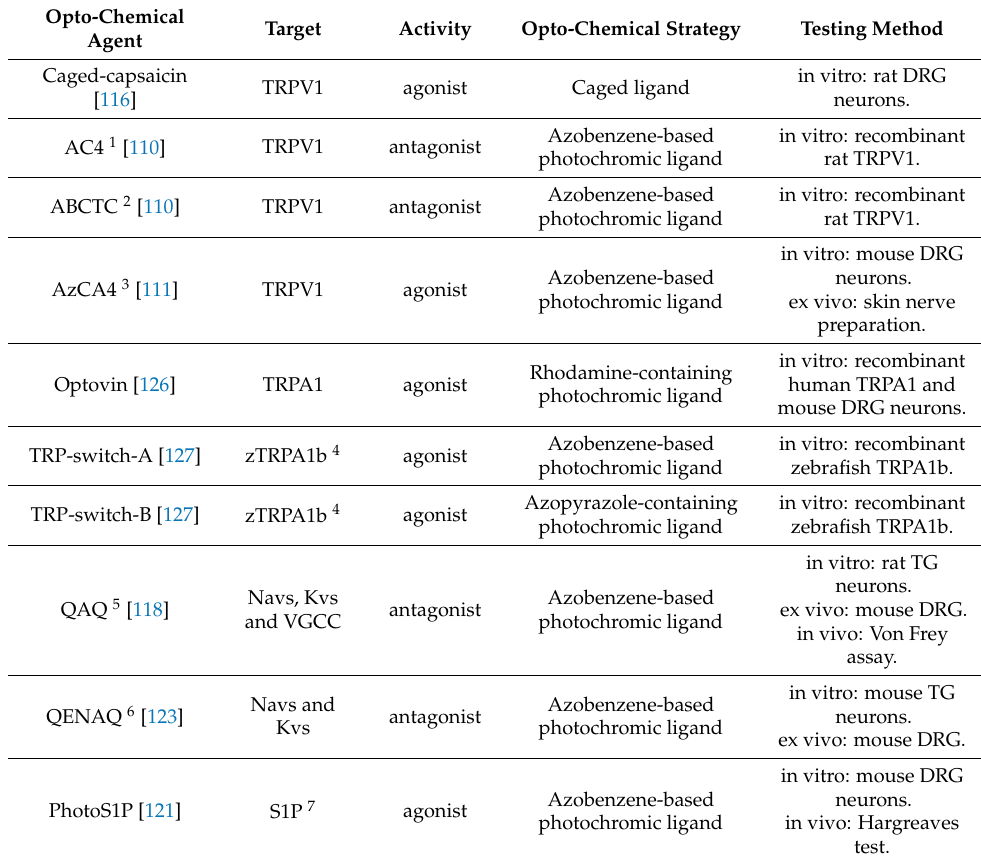
Table 1. Summarizing the opto-pharmacological compounds used for modulation of nociceptive TRP channel activity and/or nociceptive neuron